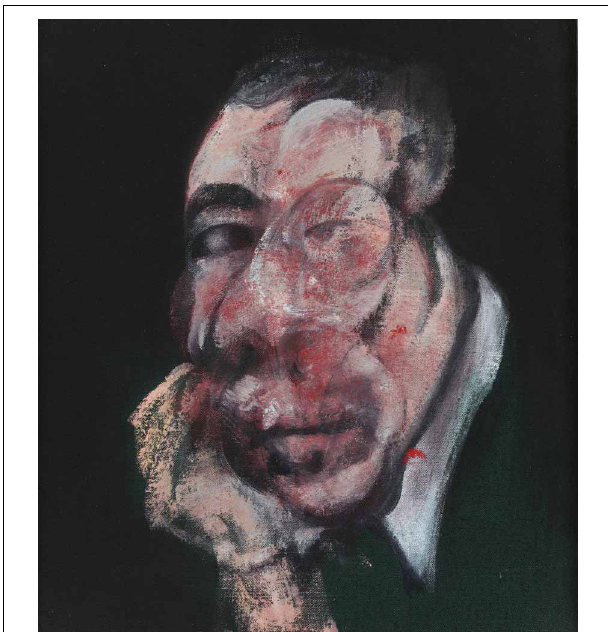
FIGURE 7 | Francis Bacon— Head III, 1961. © The Estate of Francis Bacon. All rights reserved. DACS 2013.